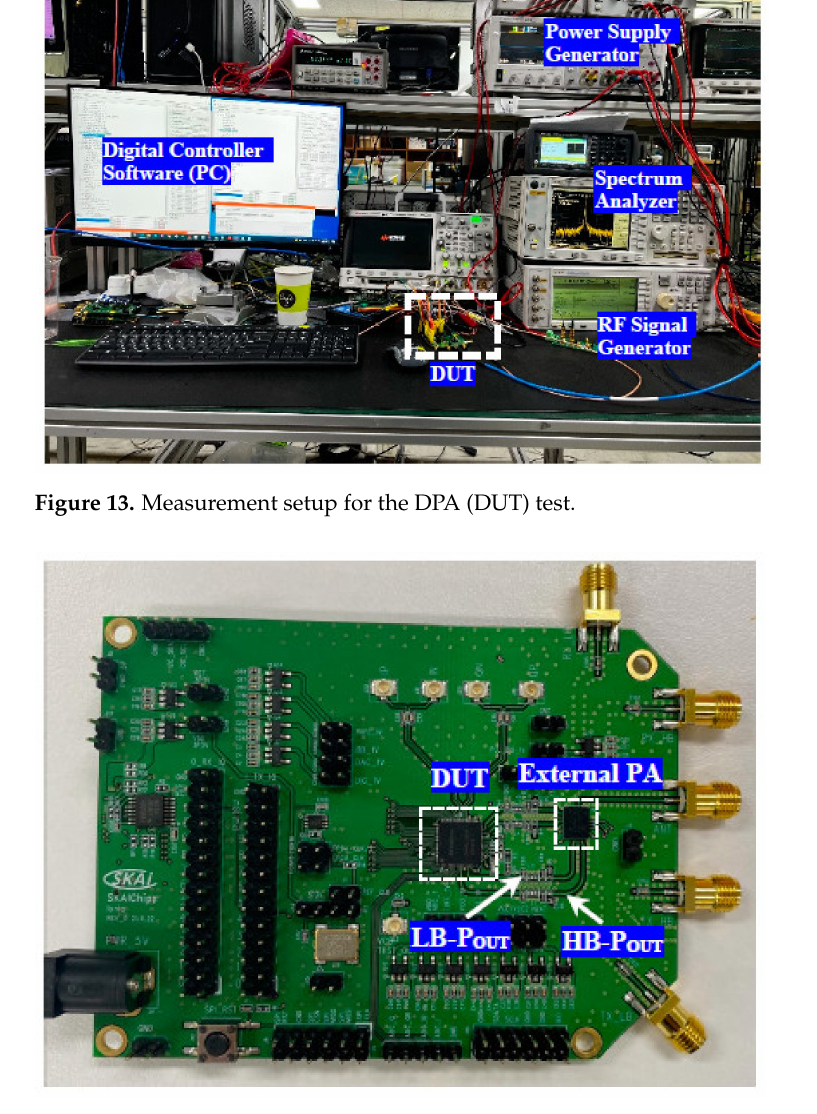
Figure 14. The test board of the DPA (DUT) showing the LB and HB paths and the external